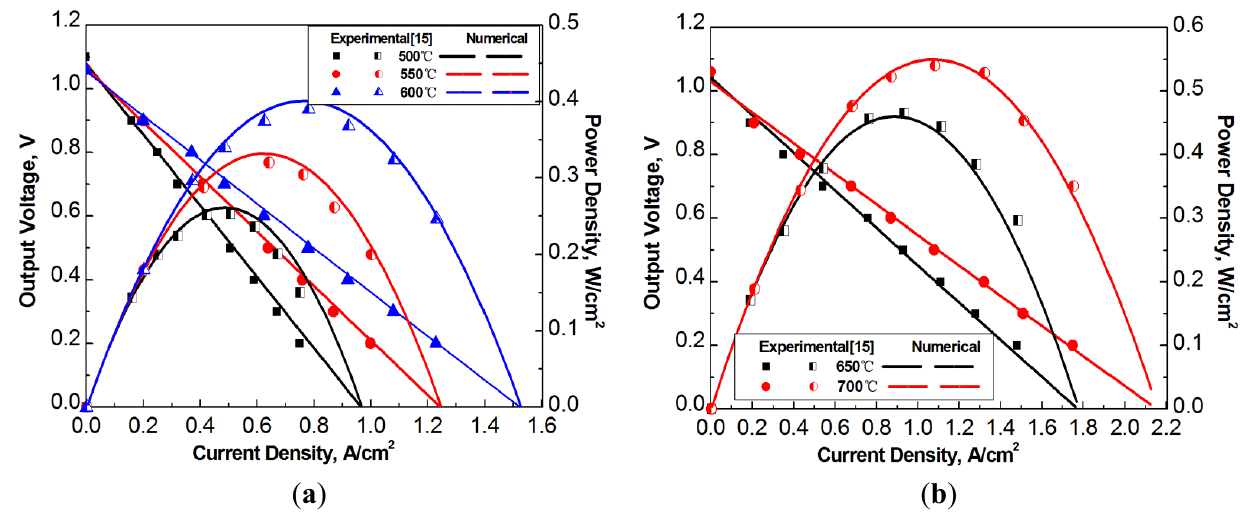
Figure 4. Comparison of present modeling results with experimental data in the reference [15]. ( a ) Operation temperature varies from 500 °C to 600 °C; ( b ) Operation temperature varies from 650 °C to 700